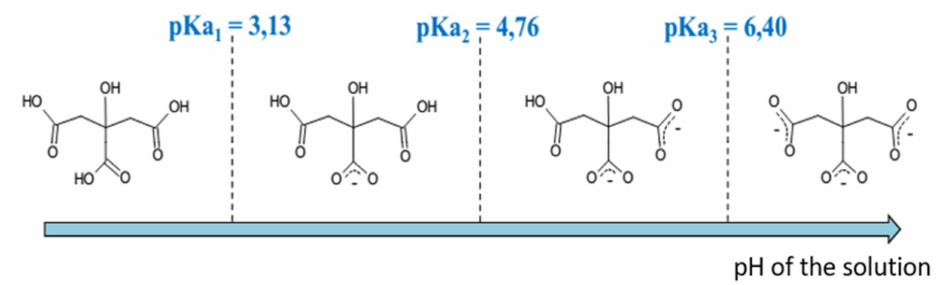
Figure 8. Evolution of the predominant species of citric acid as a function of the evolution of the pH of the solution.